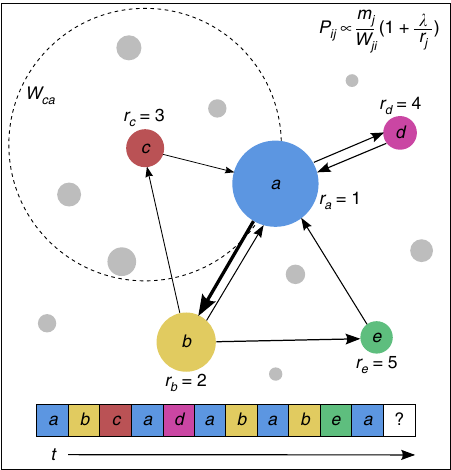
Fig. 2 Model illustration. A typical trajectory visiting the fi ve locations denoted by letters a − e with different colors is indicated at the bottom: a → b → c → a → … . The size of the circles that contain a letter indicates the relative attractiveness of the corresponding location as characterized by the index r j , where r 1 is the most attractive location, r 2 is the second most attractive one, and so on. The dashed circle centered at location c indicates that the travelers moves from c to a , whose radius is the distance between c and a , and the total population within the dashed circle is W ca . The model contains a single parameter, λ , which can be determined from each set of empirical